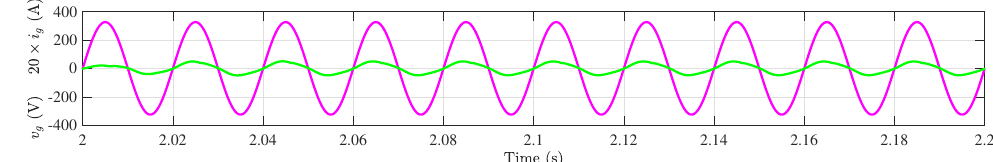
Figure 7. Time-domain waveforms of the grid voltage v g and grid current i g for S = 200 W/m 2 in steady-state operation. V M = 3.2